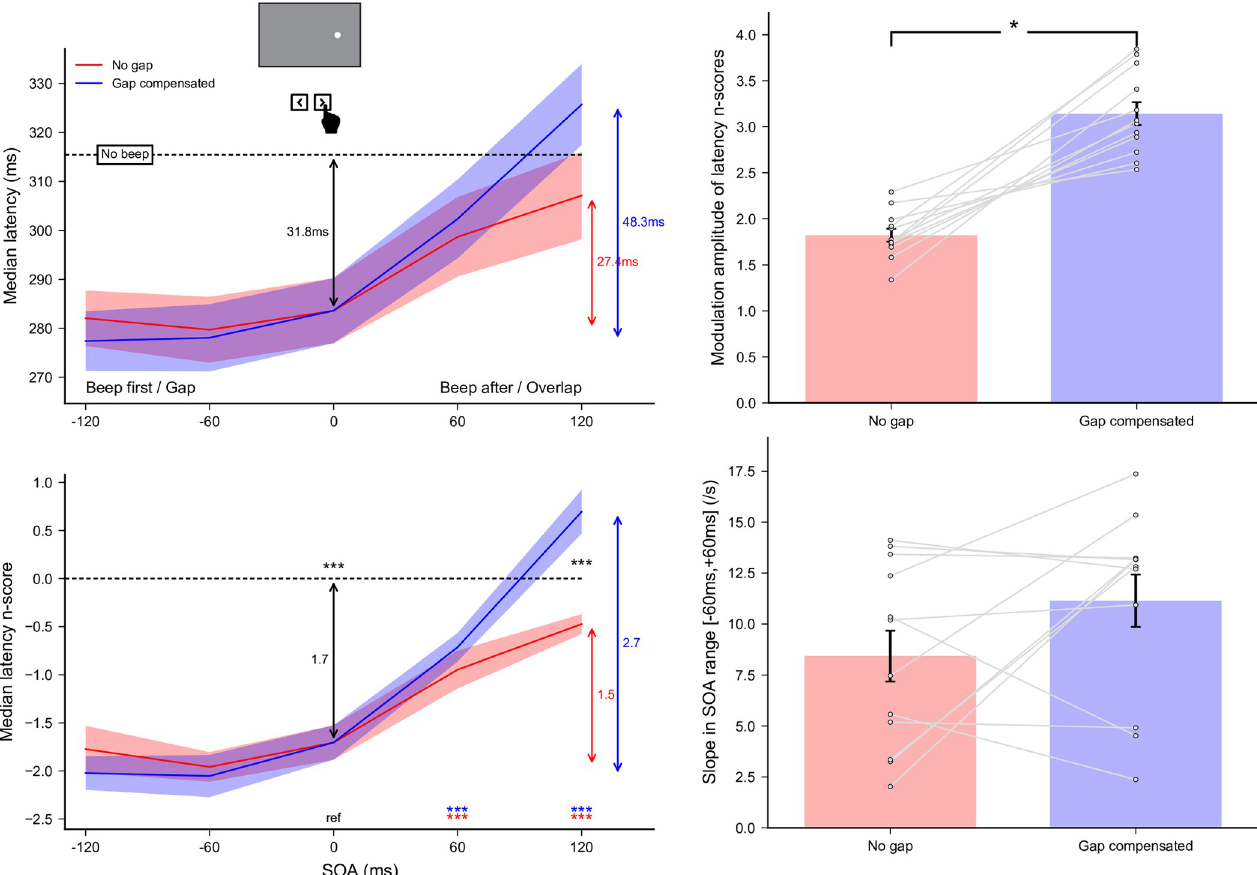
Fig 5. Experiment 1b. Effect of gap compensation on MRTs. (Left panel) Median latencies averaged across participants for the No gap and Gap compensated conditions as a function of SOA (top) and their corresponding n scores (bottom). Dashed lines show the No beep baseline condition level. Statistics performed on the n scores included a single sample t-test to compare the 0-ms SOA reference condition with the No beep condition (black arrow), and for each gap factor separately, paired t-tests compared this reference with each SOA condition (colored stars for each SOA above the X-axis). Finally, paired t-tests compared No gap and Gap compensated conditions for each SOA (black stars between curves). Three stars indicate highly significant differences for the paired t-tests after Bonferroni correction (p < 0.00556). (Right panel) Modulation amplitude of latency median n scores (top) and slopes of the linear regressions within the range [ − 60 ms, +60 ms] (bottom) computed for each gap factor. Grey lines show individual results and error bars indicate inter-individual SEM.